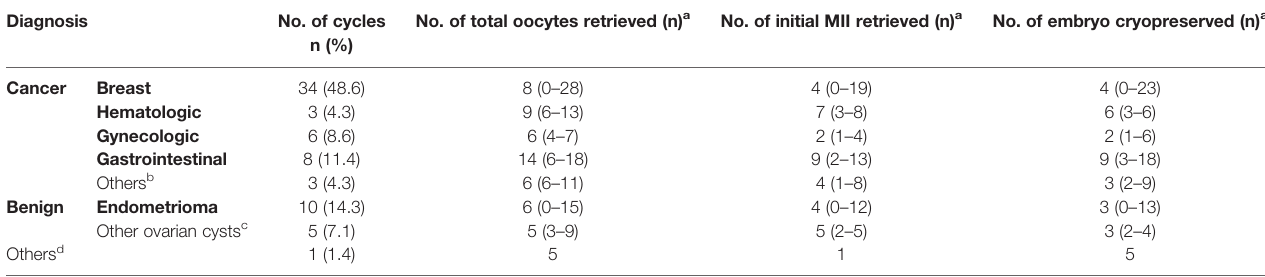
TABLE 3B | The outcomes of the controlled ovarian stimulation cycles of embryo cryopreservation (70 cycles). Diagnosis